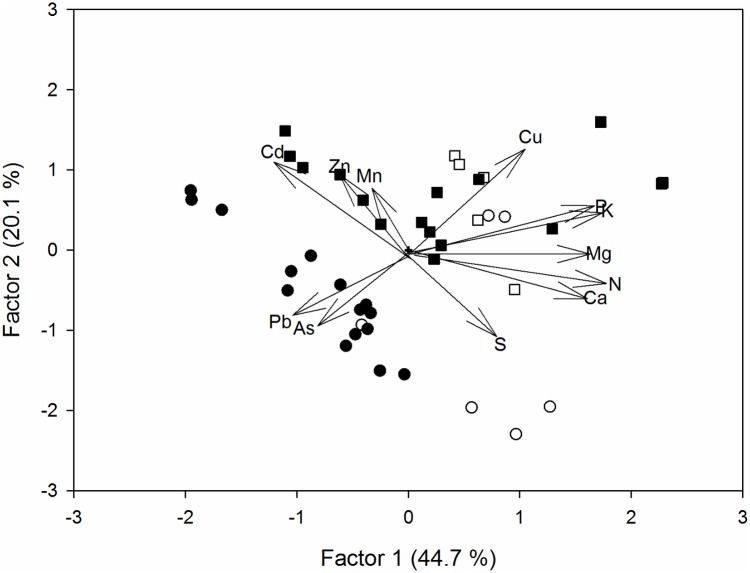
Results of the principal component analysis (PCA) of E. camaldulensis chemical composition.Symbols are circles for leaves and squares for flower buds; those sampled in contaminated sites are indicated in black and those in clean sites in white. Vectors represent the eigenvector coefficients (multiplied by two, for clarity) of the 12 elements.